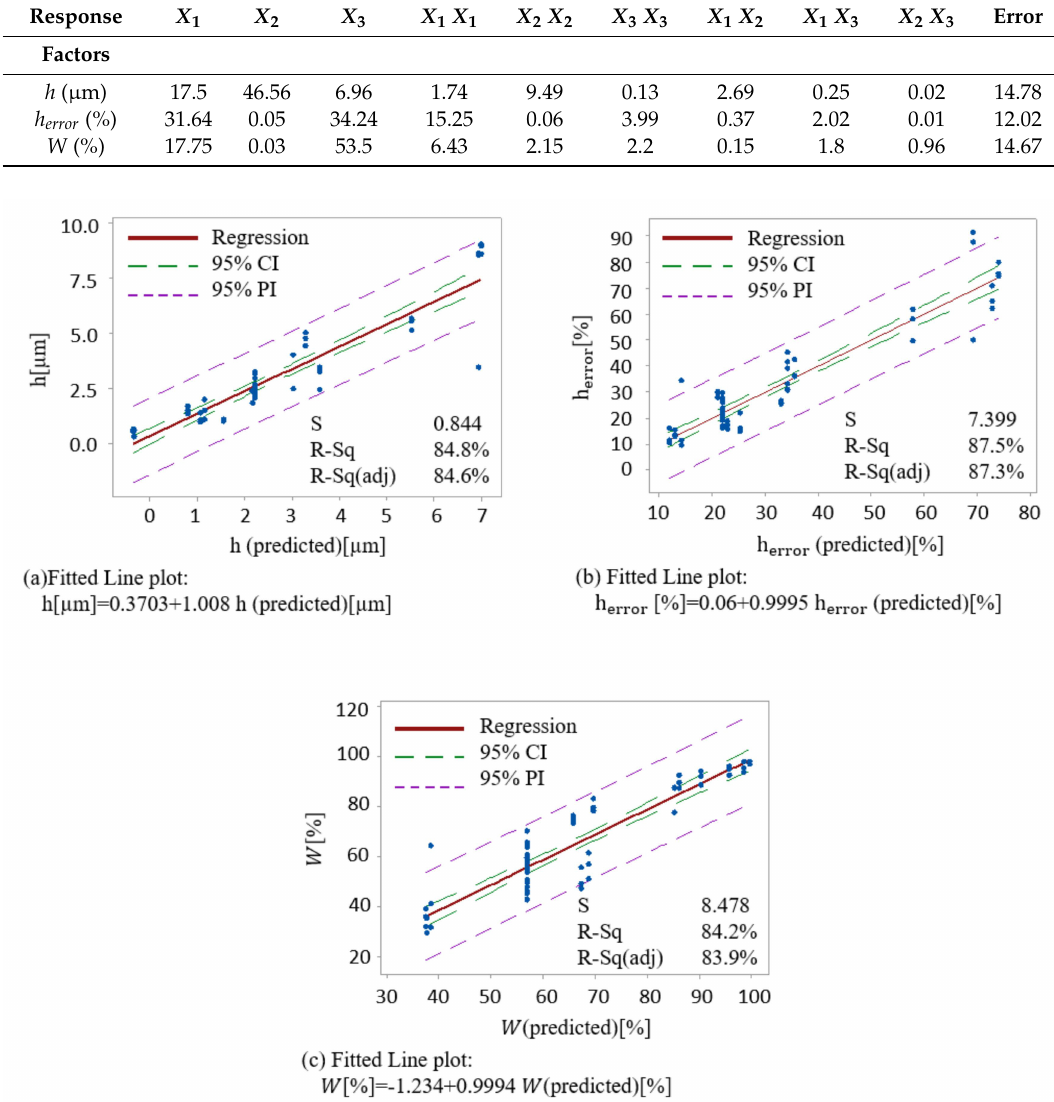
Figure 6. Correlation fitted line plots between experimental and predicted values for each of ( a ) structures height, ( b ) structures height error, and ( c ) surface